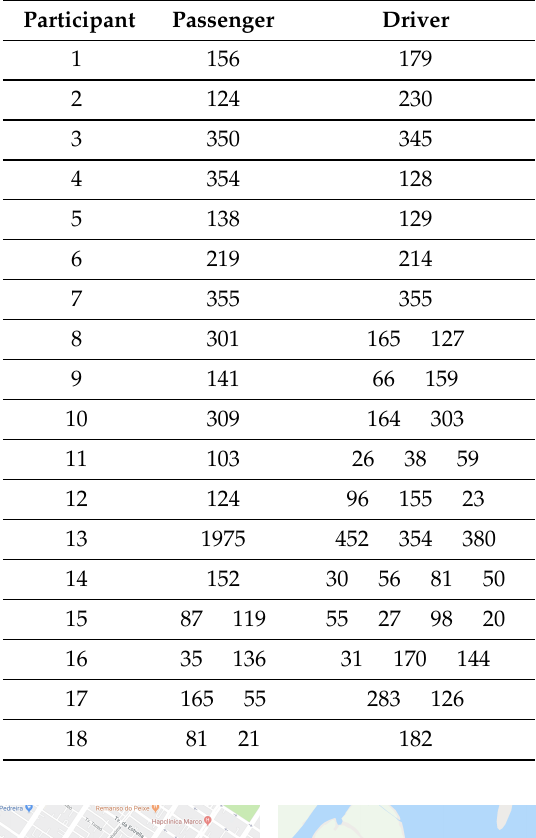
Table 1. Number of messages read by each volunteer. The subdivision of the driver or passenger column indicates that the volunteer has performed more than one trip with that